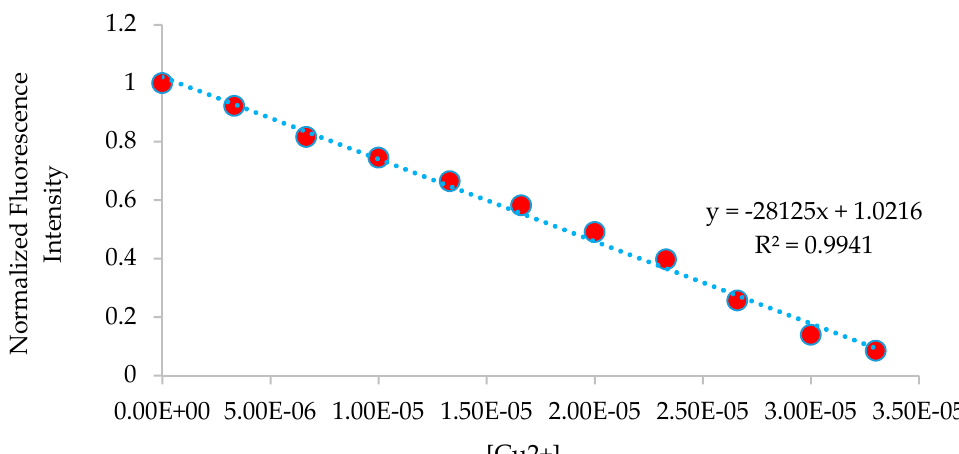
Figure 7. The linear relationship (trend line in blue) between fluorescence intensity and Cu 2 + concentrations measured in methanol (pH 7.0–7.5) under λ exc = 390 nm. Fluorescence intensity data have been rescaled to have values between 0 and 1. Spectral data were recorded at 5 minutes after the addition of Cu 2 + (0.0, 0.1, 0.2, 0.3, 0.4, 0.5, 0.6, 0.7, 0.8, 0.9, and 1.0 mL) to H 2 SB (1.0 mL) at r.t.